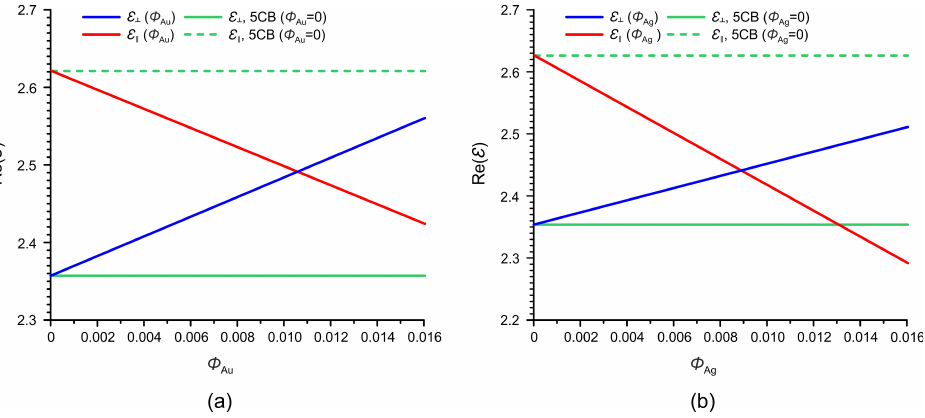
Figure 4. Real parts of the transverse and longitudinal components of the high-frequency dielectric susceptibility of the 5CB nematic nano-composites as functions of the volume fraction of gold ( a ) and silver ( b ) nanoparticles for the cyclic frequency of 3.5